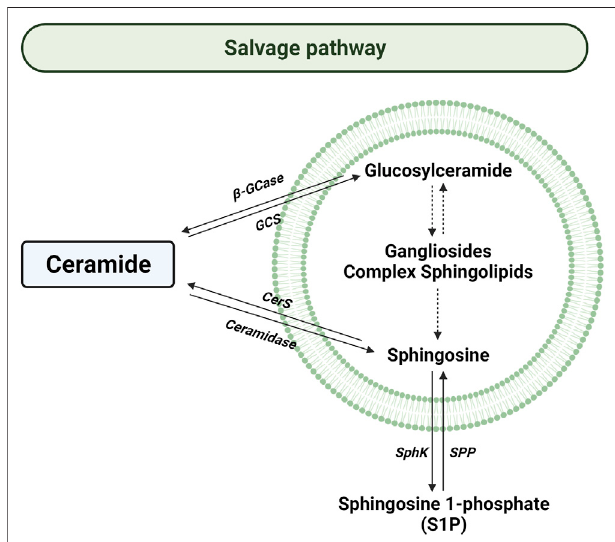
FIGURE 4 | Salvage pathway. Solid arrows represent single reactions, whereas dashed arrows represent various step reactions. Acid β -glucosidase ( β -GCase), glucosylceramide synthase (GCS), ceramide synthase (CerS), sphingosine kinase (SphK), and sphingosine 1-phosphate phosphatase (SPP) are represented by their acronyms. The lipid bilayer represents